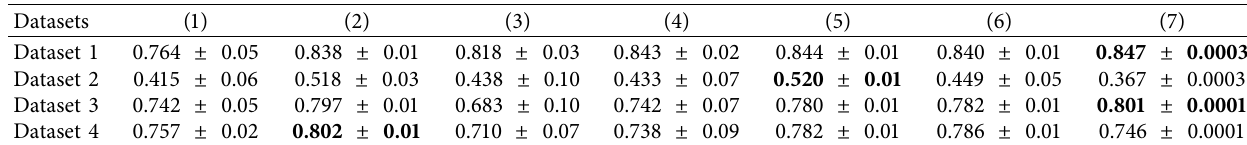
Table 5: The mean accuracy results (with standard deviation) of various data augmentation techniques for Vietnamese sentiment analysis in 10 runs based on the deep learning model.